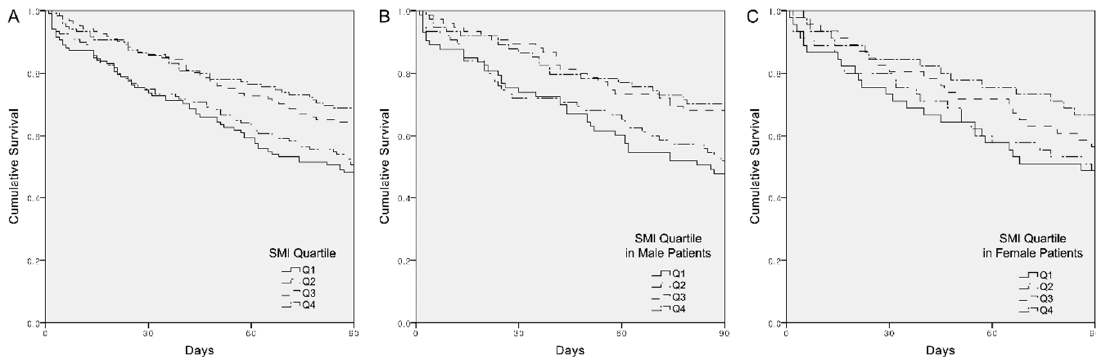
Figure 2. Kaplan–Meier survival curve estimates of 90-day mortality in ( A ) overall, ( B ) male, and ( C ) female patients according to their skeletal muscle index (SMI) quartiles.